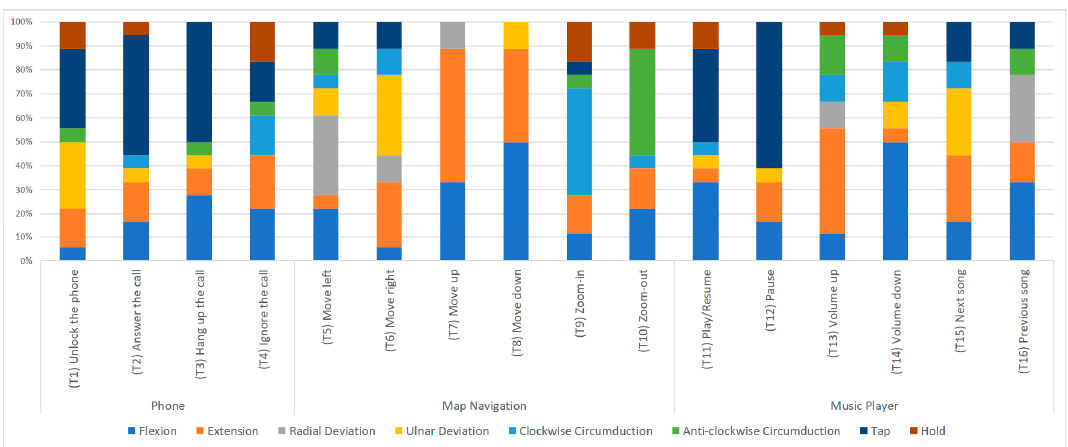
Figure 3. Frequency distribution of the wrist and touch gestures used for the 16 commands (along the horizontal axis). They are grouped based on the three categories. Tap gestures were used for state toggles (e.g., pause).